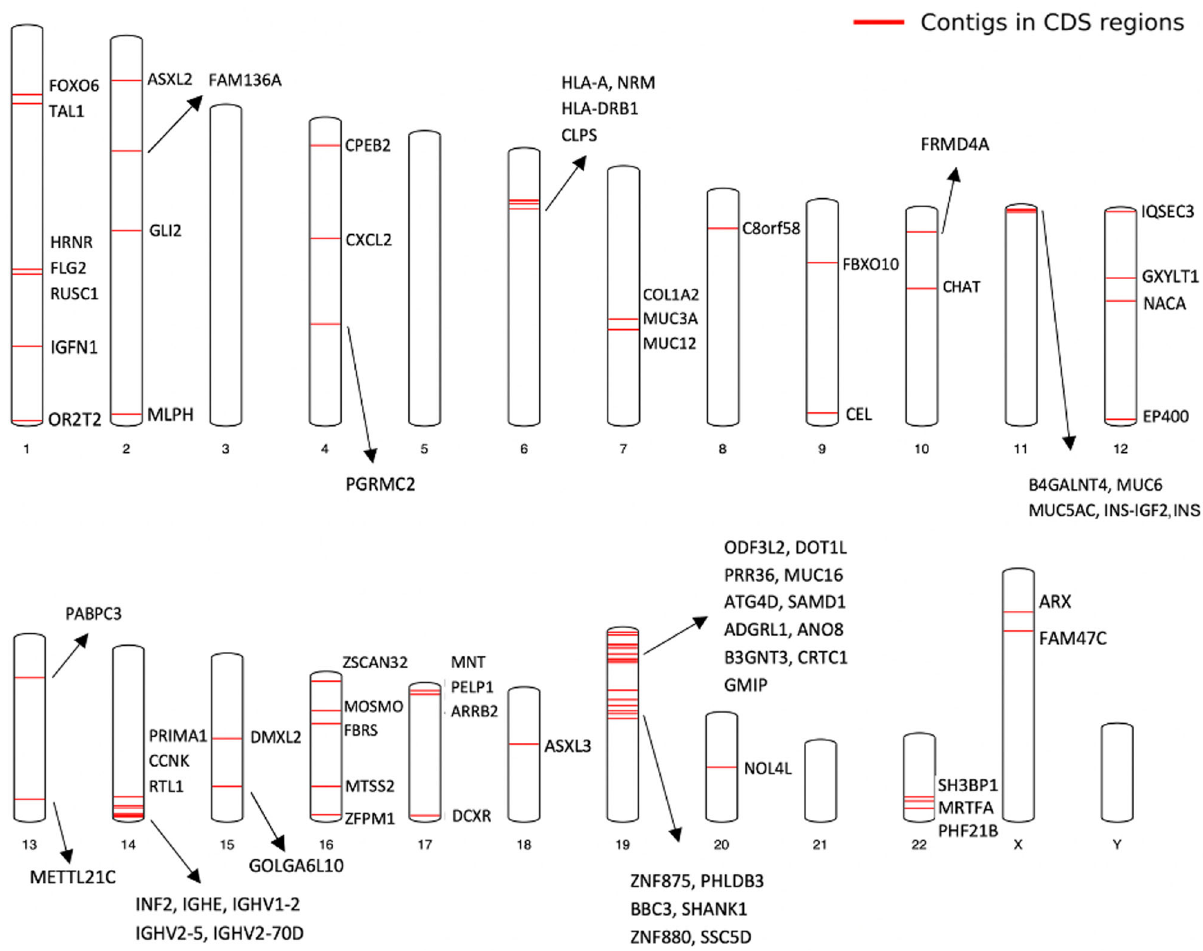
Fig. 5 Chromosome locations of the novel CPG sequences inserted in CDS regions. In the genome map, the red lines represent the novel CPG sequences located in coding sequence (CDS) regions and the corresponding gene symbols are listed. Detailed annotation information was reported in Supplementary Data